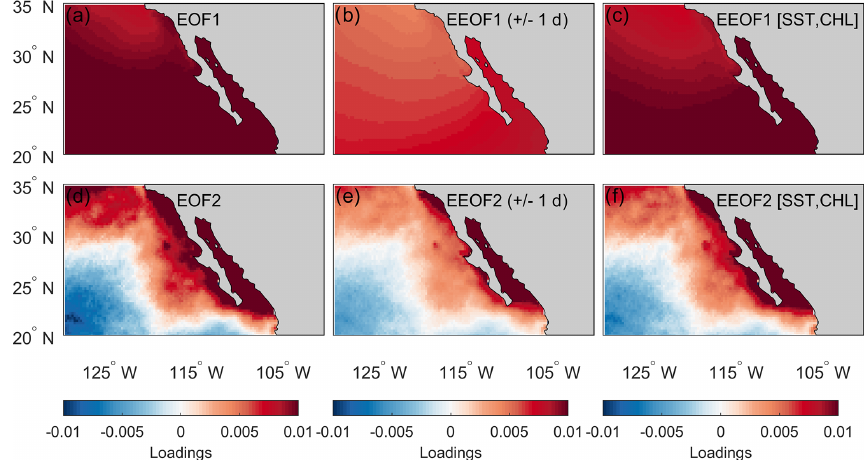
Figure 3. Example of decomposing chlorophyll into different modes by using an (a, d) empirical orthogonal function, (b, e) an extended empirical orthogonal function with 1d lead and lag, and (c, f) an extended empirical orthogonal function with sea surface temperature